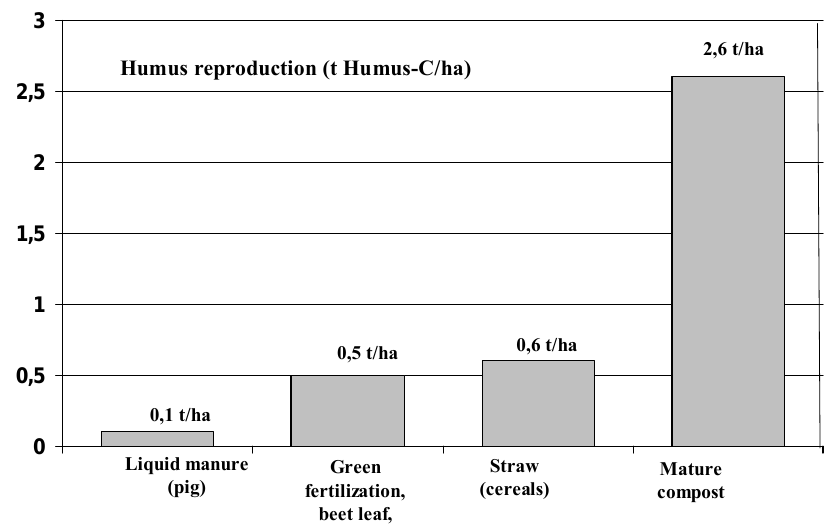
Figure 24: The efficiency of organic fertilisers for the humus structure (Kehres 2008) With compost and its high contents of organic matter resistant to degradation more than 2,500 kg Humus-C/ha are applied. The effectiveness on the humus reproduction is by factor 4 higher than with straw and by factor 20 higher than with liquid